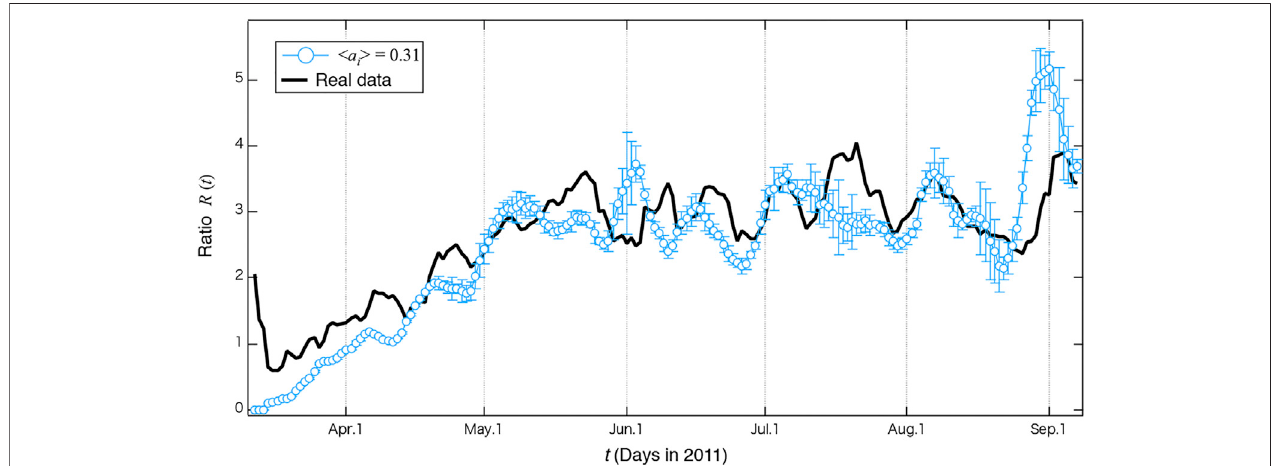
FIGURE 5 | Simulation results for 〈 a i 〉 (cid:1) 0.31, which is the most accurate reproduction of the real data. The error bars represent the standard deviation calculated from ten iterations.